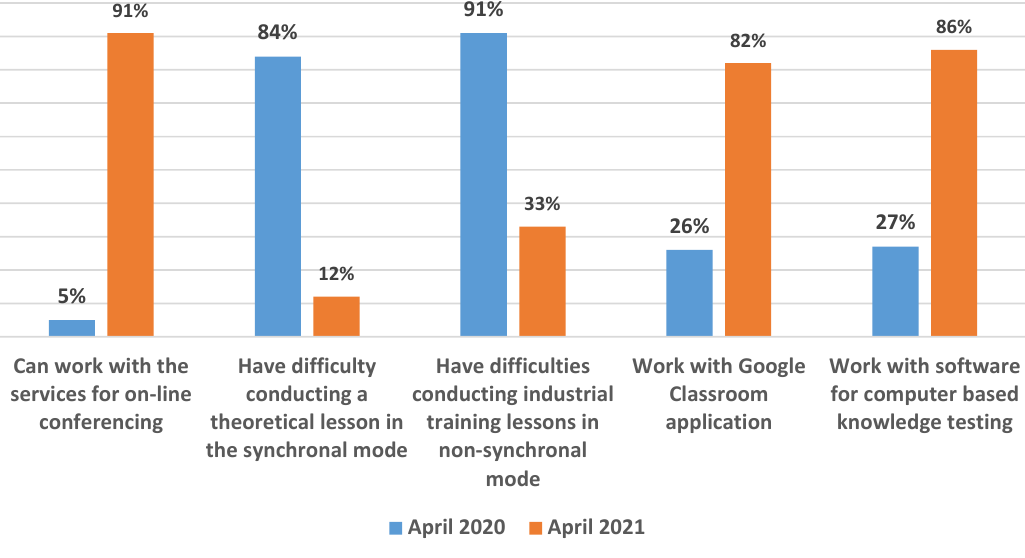
Figure 3: Improvement of VS teachers’ software skills of maintaining distant and mixed forms of education